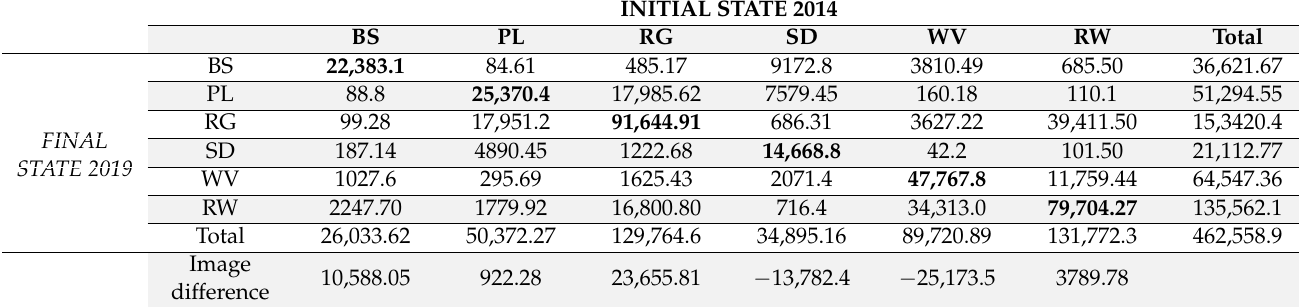
Table 7. Change matrix of the rainfed agriculture and other LULC types of North Darfur State in hectares from 2014 to 2019. The bold values in the change matrix indicate unchanged land types between the initial and final